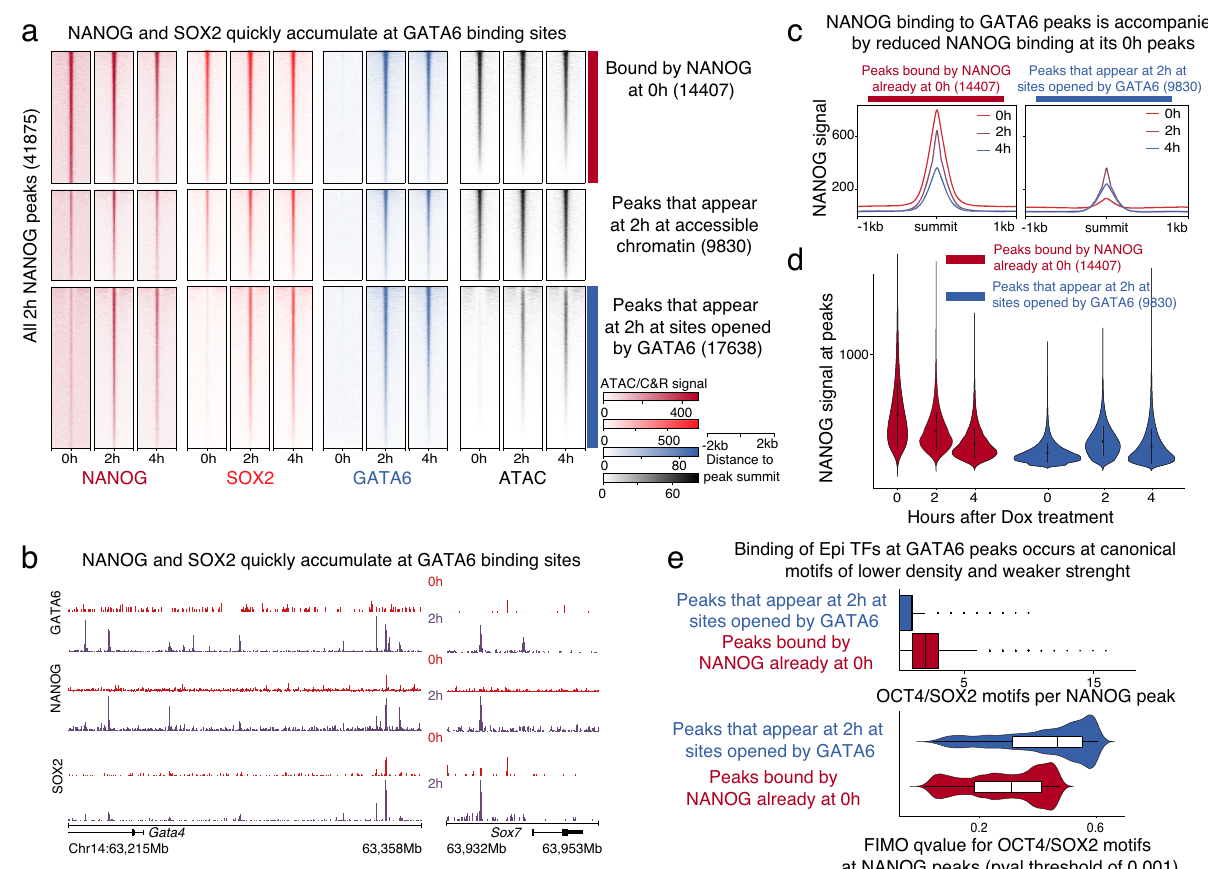
Fig. 4 Evicted pluripotency factors transiently occupy GATA6-bound PrE regions. a Heatmap showing NANOG, SOX2, and GATA6 binding, together with ATAC signal at regions of the genome bound by NANOG at 2 h. These NANOG peaks were divided in three types: occupied already at 0 h (cluster 1-red), bound de novo by NANOG at 2 h and accessible at 0 h (cluster 2), and bound de novo by NANOG at sites closed at 0 h (cluster 3 -blue). b Representative browser view showing the de novo recruitment of NANOG and SOX2 at 2 h at GATA6 peaks found at putative CREs controlling PrE genes GATA4 and SOX7. c Median pro fi le plots showing a reduction in NANOG binding at NANOG 0 h peaks (left panel, cluster 1 from A) with a simultaneous increase in NANOG binding at peaks opened by GATA6 binding (right panel, cluster 3 from A). d NANOG CUT&RUN signal from 0, 2, and 4 h post Dox induction plotted at peaks comprising clusters 1 and 3 in 4a. The violin plot shows a decrease of read density at cluster 1 peaks with a simultaneous increase at cluster 3 peaks. e Peak per motif density and strength of OCT4-SOX2 binding motifs within NANOG peaks that appear at 2 h (blue) compared to NANOG peaks de fi ned at 0 h (red). Motif strength is represented by the q -value of the FIMO analysis comparing the motif found at peaks to the consensus sequence. Boxplots show minimum, maximum, median, fi rst, and third quartiles. Source data are provided as a Source Data fi